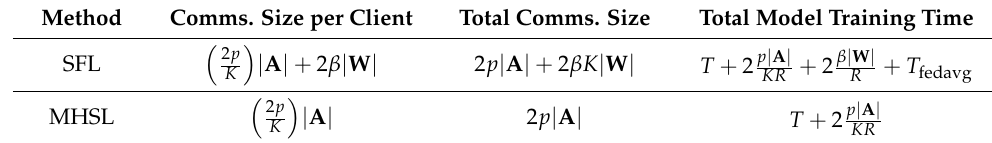
Table 3. Communication size and model-training-time equations for SFL and MHSL for one global epoch. Method Comms. Size per Client Total Comms.